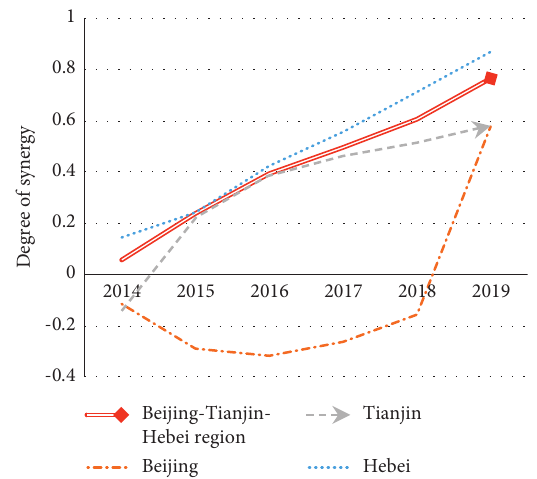
Figure 3: The degree of synergy of the Beijing-Tianjin-Hebei complex